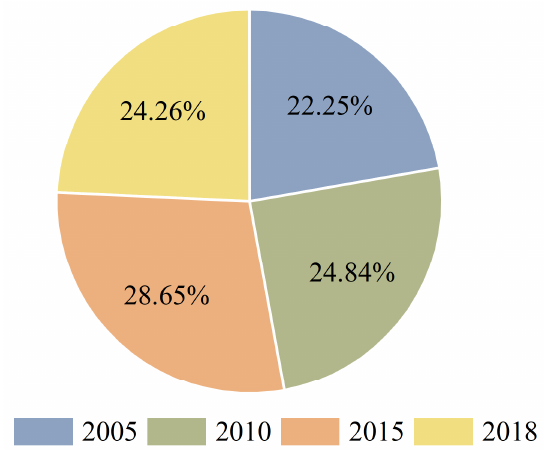
Figure 7. The ratio of total multi-year water consumption by year.